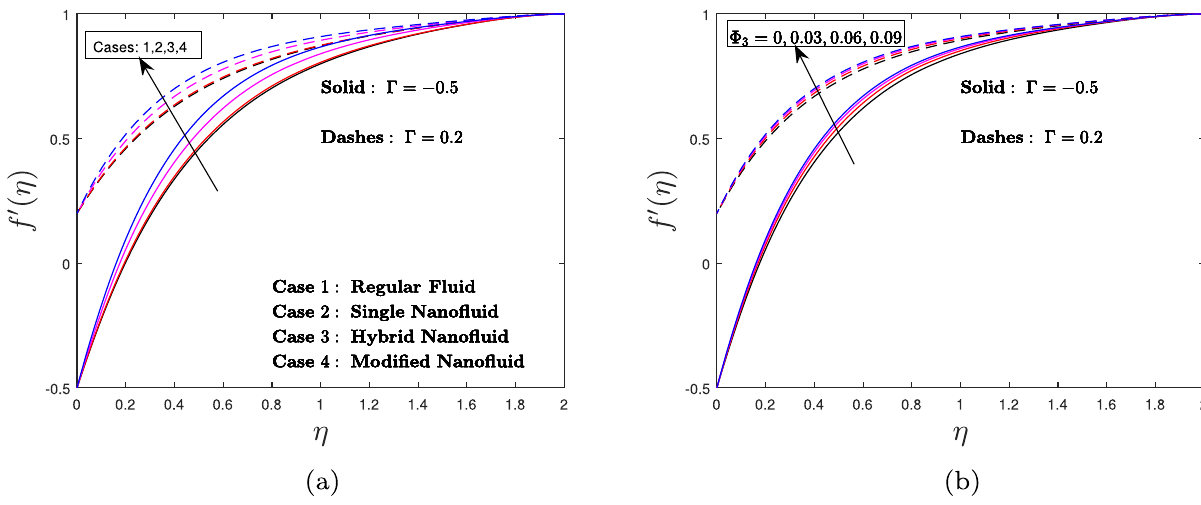
Figure 6: Behaviour of ( a ) regular fl uid, SNF, HNF, MNF, and ( b ) Φ 3 on velocity fi elds.